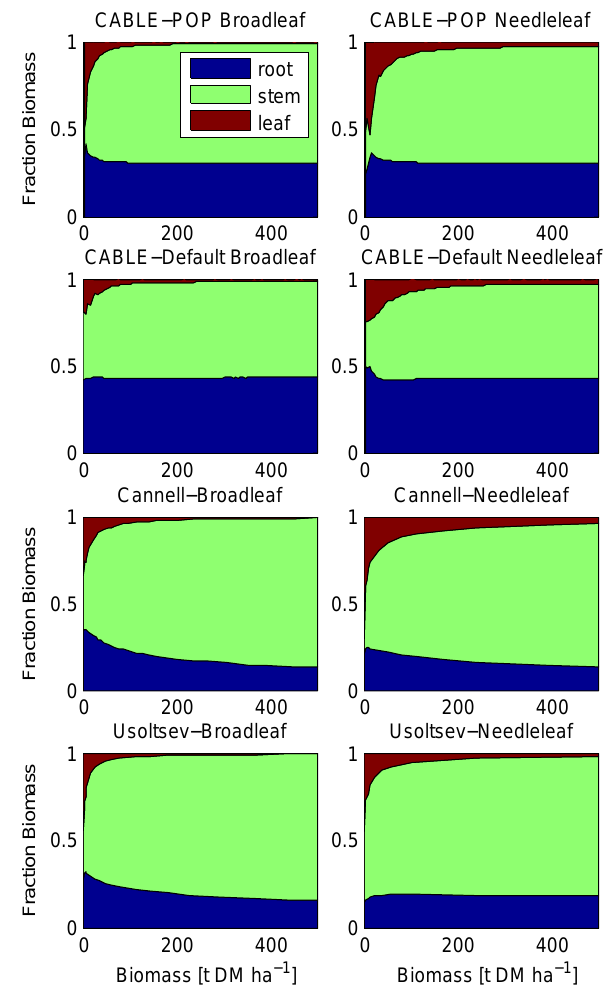
Figure 5. Biomass component fractions as a function of total biomass: top: CABLE-POP patches; second row: default CABLE; third and bottom rows: data-derived estimates reproduced from Wolf et al.